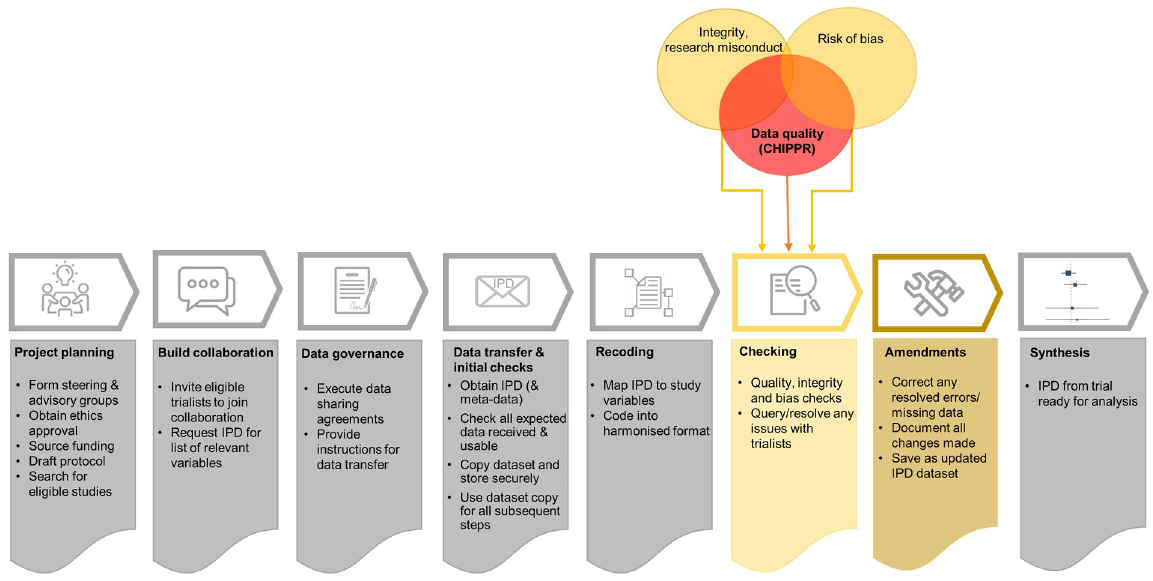
Fig 1. Stages of an individual participant data meta-analysis, highlighting where CHIPPR fits in and interrelated types of data checks (adapted from Rydzewska & Tierney) [4].